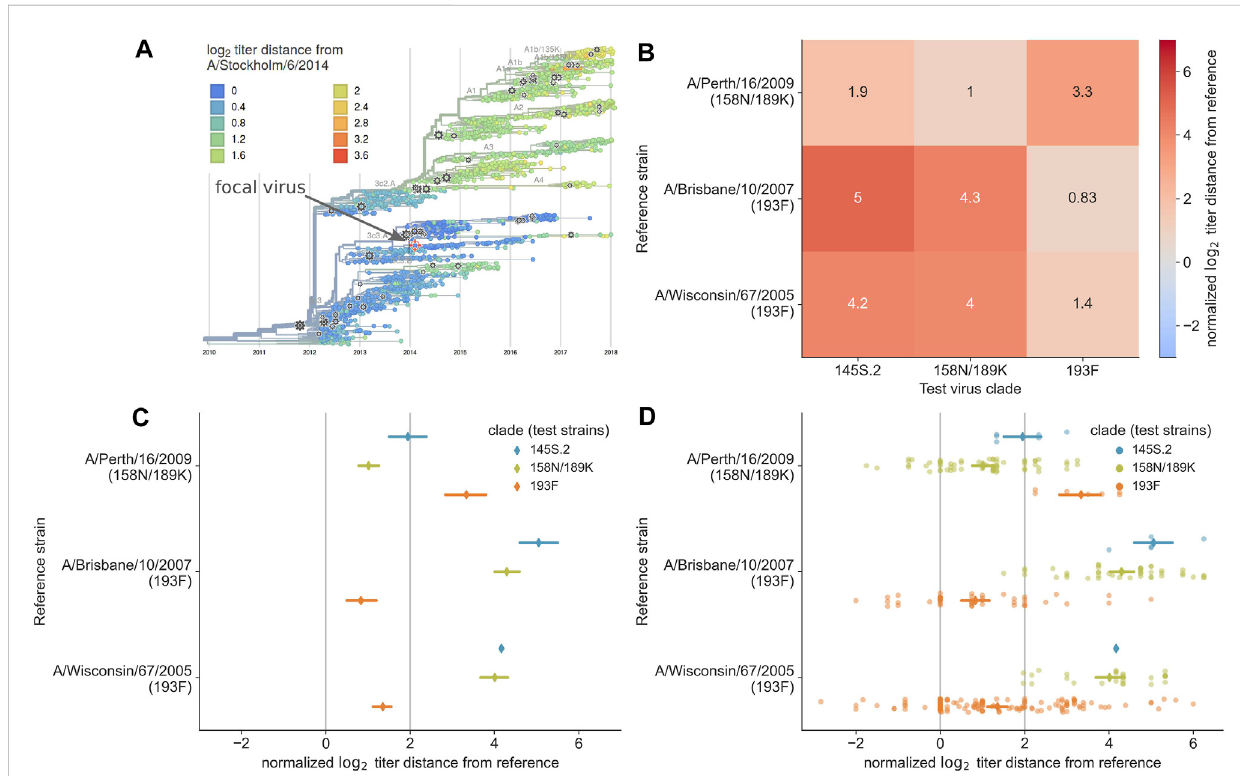
FIGURE 1 Previous approaches to static visualization of serological data for seasonal in fl uenza vaccine composition reports. (A) Phylogenetic visualization (Neher and Bedford, 2018) allows the user to select a single vaccine candidate (e.g., A/Stockholm/6/2014) and see how well that virus might cover other circulating viruses in their genetic context based on the antigenic distance encoded by color (orange and red color indicate greater distance and less coverage by the selected virus). To compare multiple vaccine candidates, users have to select different reference viruses manually and toggle between them. (B) Heatmap visualization of mean antigenic distances between multiple vaccine candidates (reference viruses on the y -axis) and viruses in currently circulating phylogenetic clades. Heatmaps encode distance by color and text, allowing the user to compare how well multiple vaccine candidates might cover circulating viruses. (C) Interval plot of mean ±89% con fi dence interval values of antigenic distances between vaccine candidates ( y -axis) and viruses in currently circulating clades. Unlike the heatmap visualization, the interval plot encodes distance with a positional encoding (the x -axis) instead of color and encodes clades with color. The vertical gray lines represent the threshold above which viruses are considered antigenically